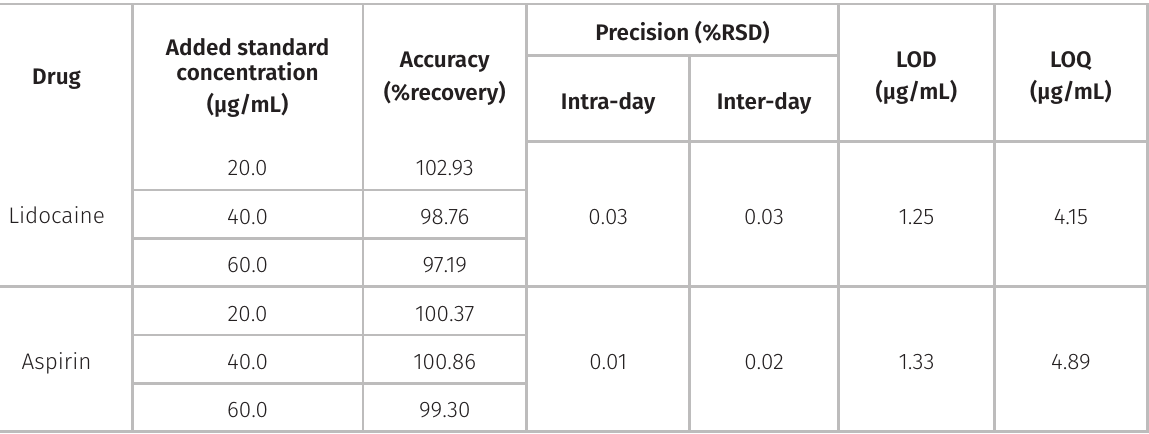
Table I. Validation results of the analytical